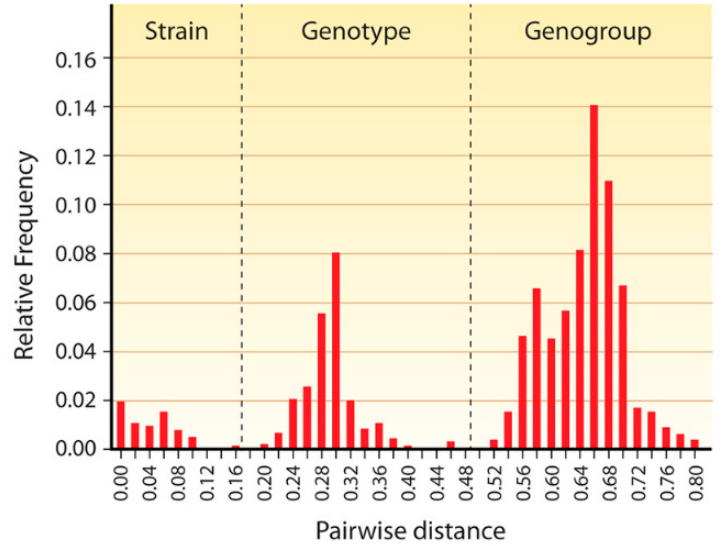
Figure 2. Pairwise distance distribution histogram of complete VP1 genes of 59 sapoviruses. The peaks of 0–0.159, 0.198–0.471, and 0.522–0.807 correspond to the distance range of strains, genotypes, and genogroups, respectively. The cut-off values for genotype and genogroup clusters were <0.169 and <0.488, respectively, and are indicated by vertical dashed lines. From reference [37], with permission of authors and publisher.